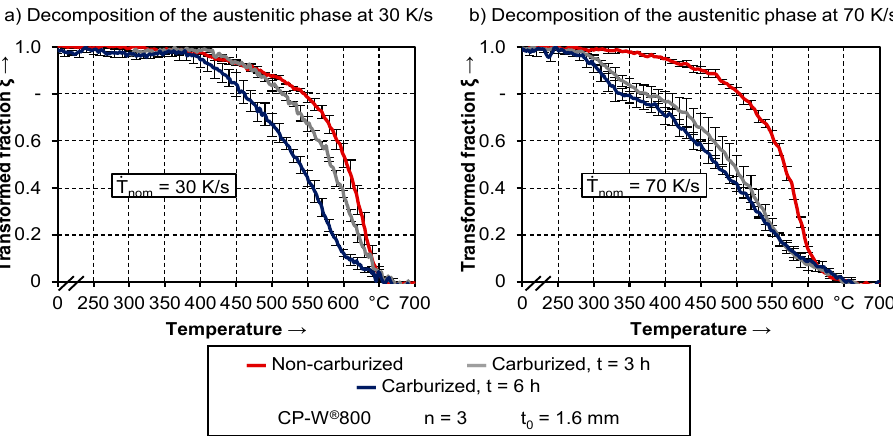
b) Decomposition of the austenitic phase at 70 K/s